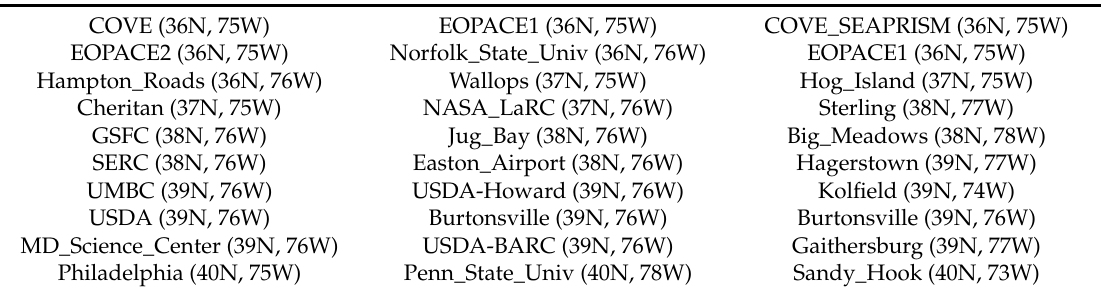
Table 4. Precipitable water observation stations in America.